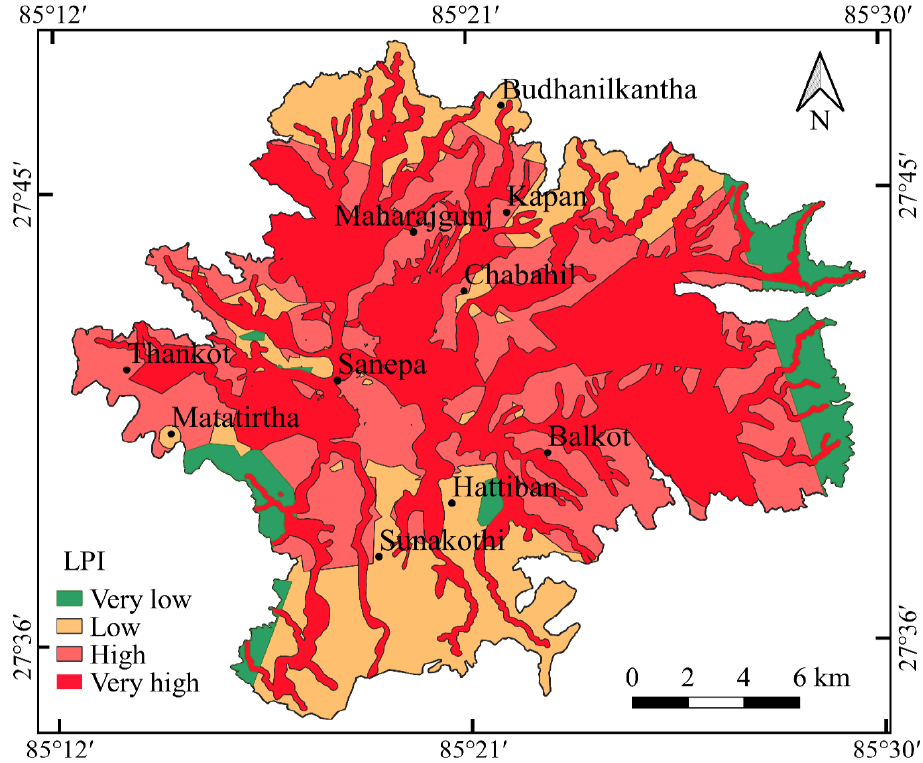
Figure 11. Liquefaction susceptibility map of Kathmandu Valley.